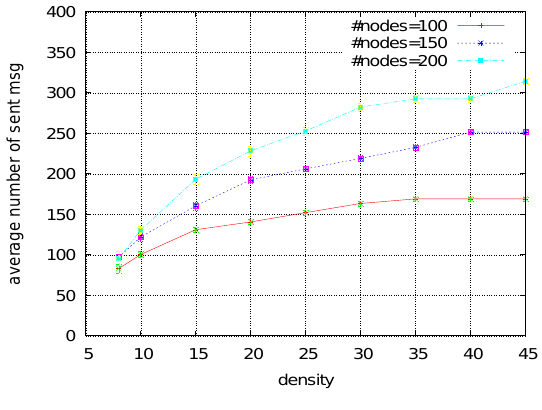
Fig. 5. Average number of messages sent per node.